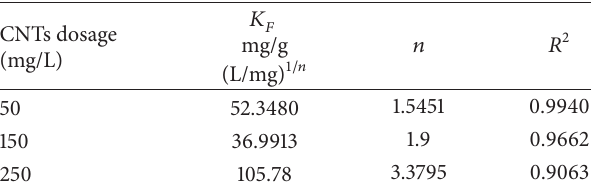
Table 3: Adsorption isotherm constants of Freundlich model for methyl violet dye (pH = 8.5 and contact time = 40min).